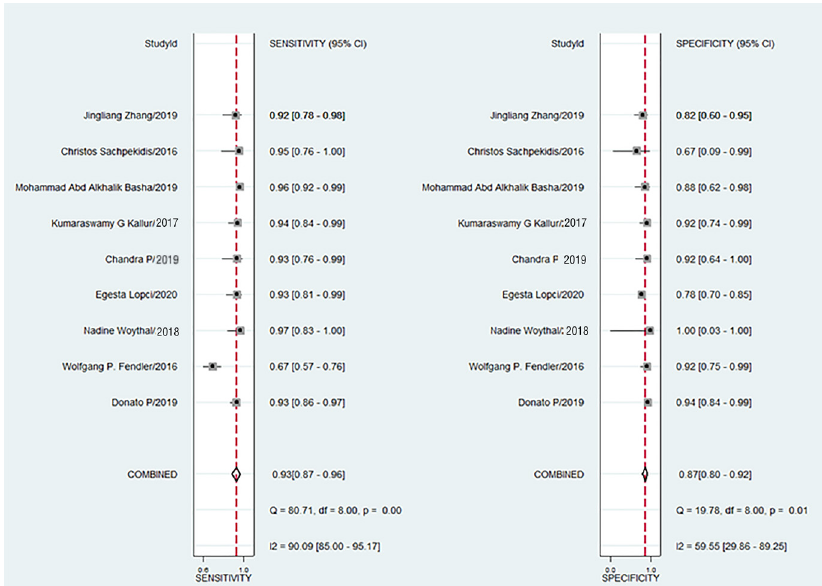
Figure 3 - Coupled forest plots of the combination sensitivity and specificity of the inclusion study. Numbers are pooled estimates of the 95% CIs in parentheses. The lower right corner provides the corresponding statistics of heterogeneity. The horizontal lines represent the 95%CIs. CI=confidence interval.